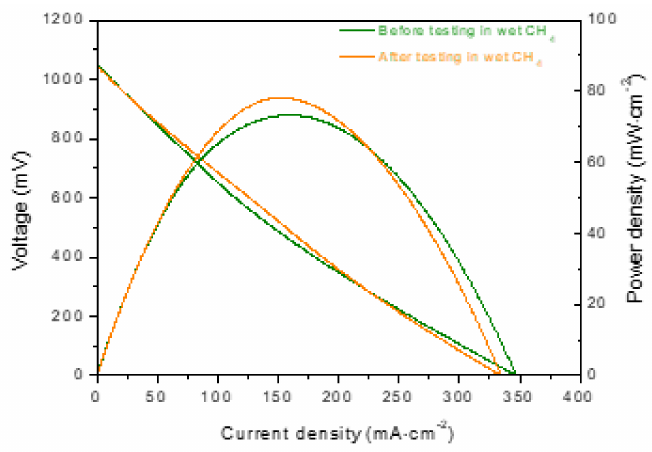
Figure 5. I-V curves of the cell (Ni-CYSZ / YSZ / LSM) at 850 ◦ C in H 2 (3% H 2 O) before and after long-term stability tests in wet CH 4 (3% H 2 O).